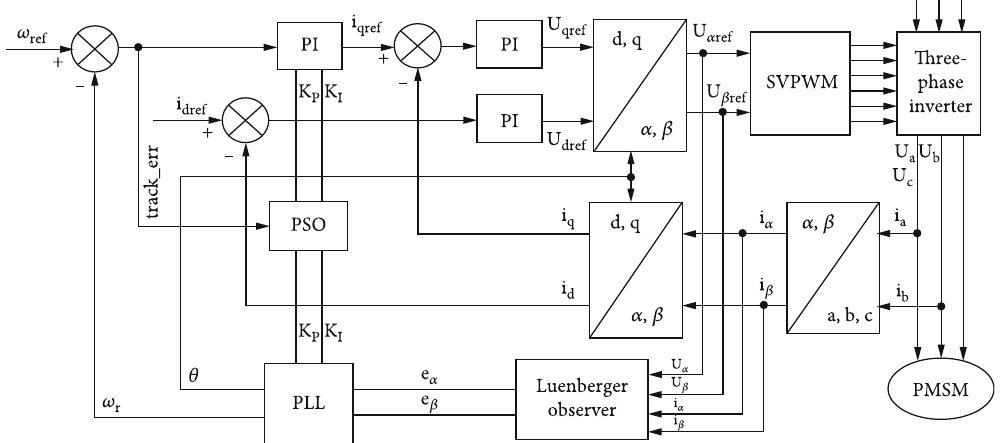
Figure 8: Block diagram of optimized PMSM sensorless control system by PSO.